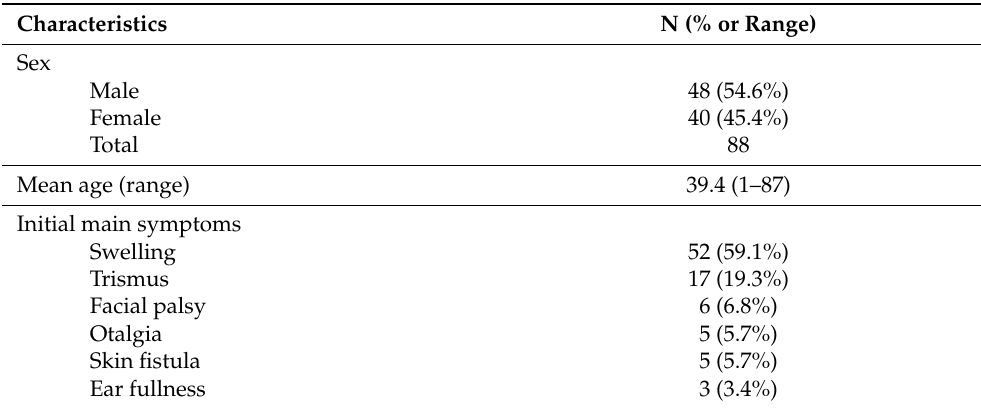
Table 1. Demographics features and clinical presentation of the parotid gland sarcomas included in this study.